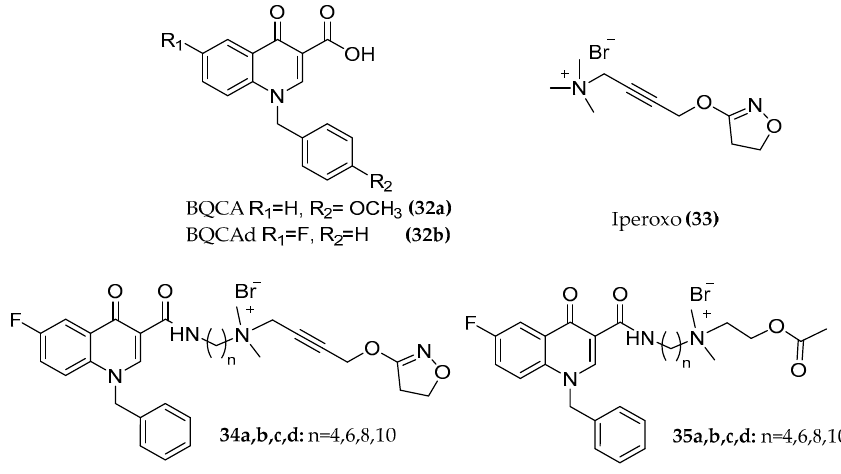
Figure 13. Structures of BQCAd/Iperoxo-ACh hybrids.